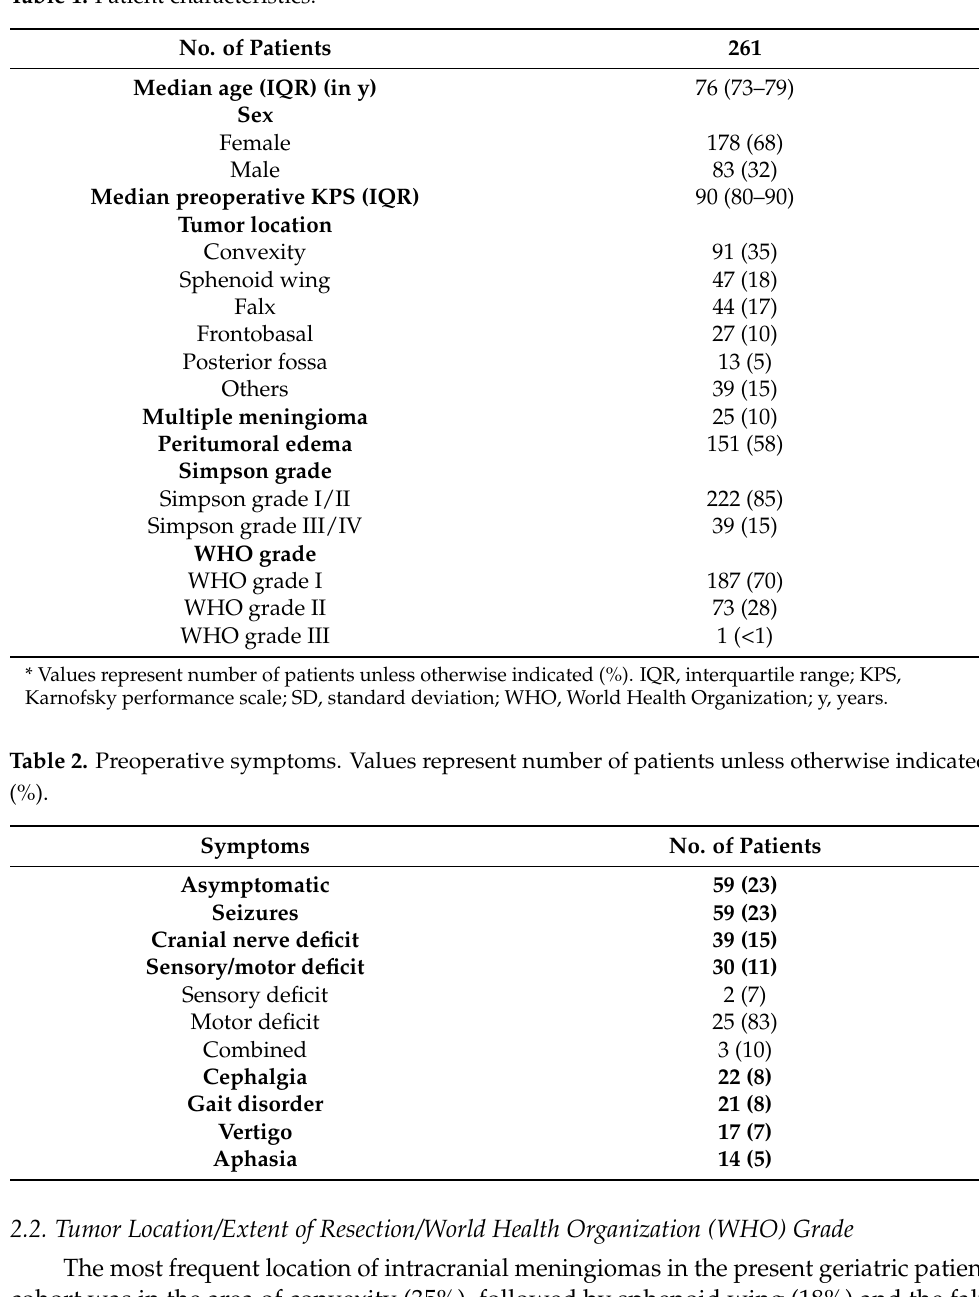
Table 1. Patient characteristics.